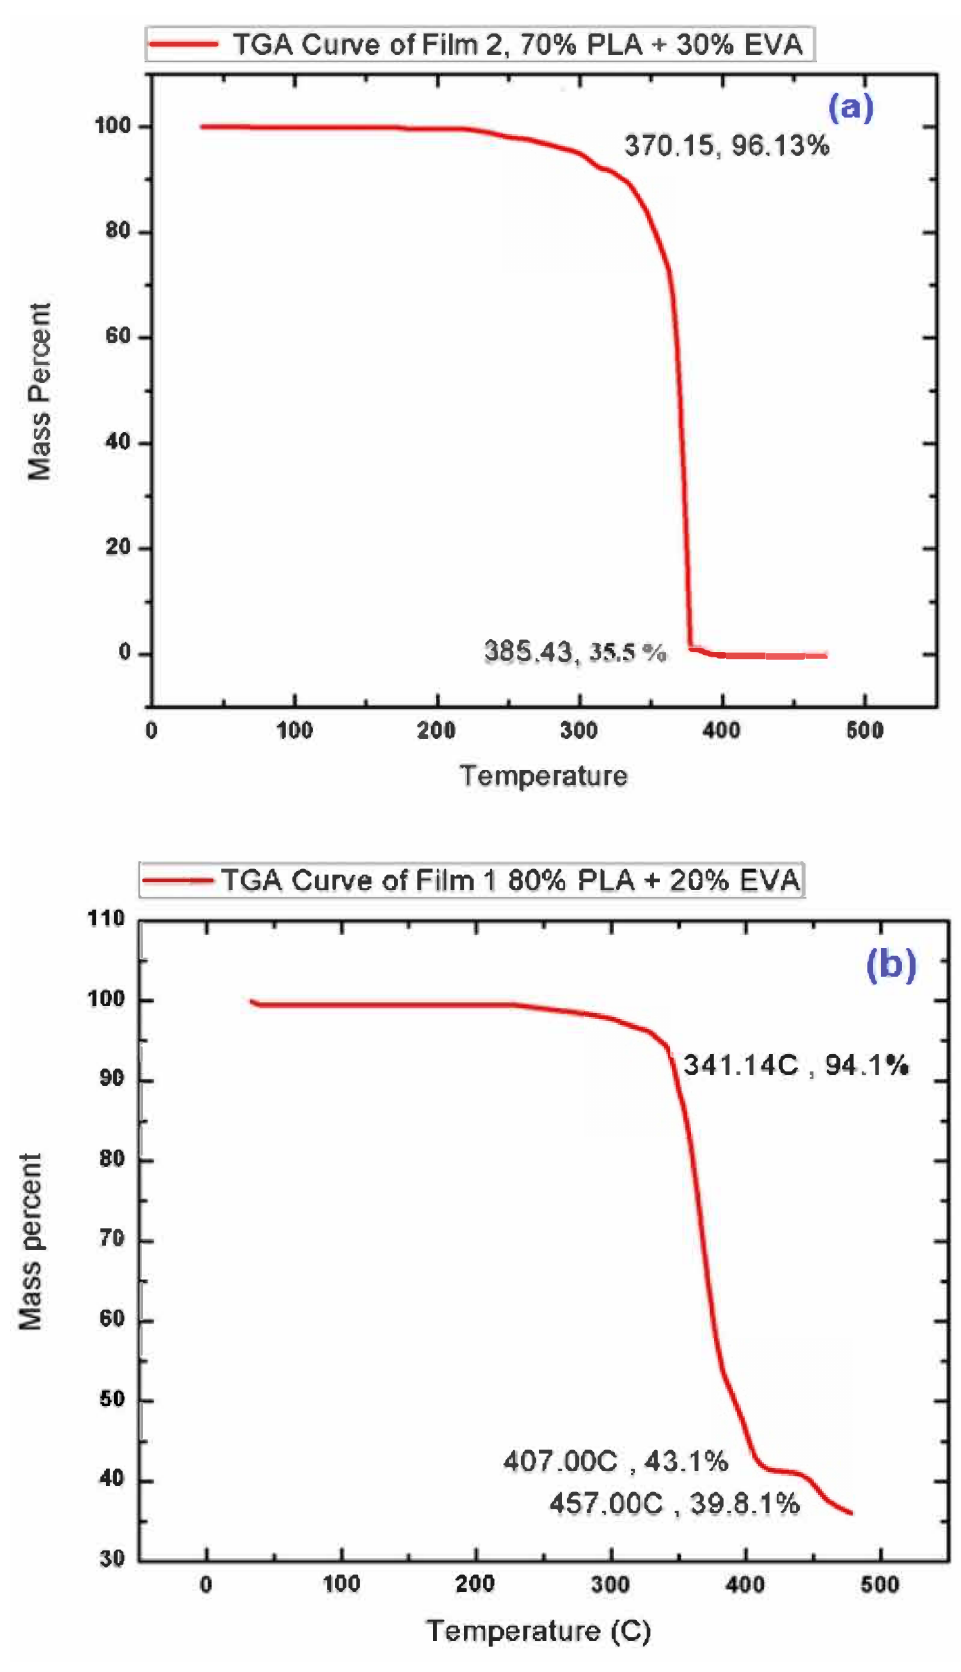
Figure 3. TGA curve of ( a ) F-1 (80% PLA & 20% EVA) and ( b ) F-2 (70% PLA & 30%